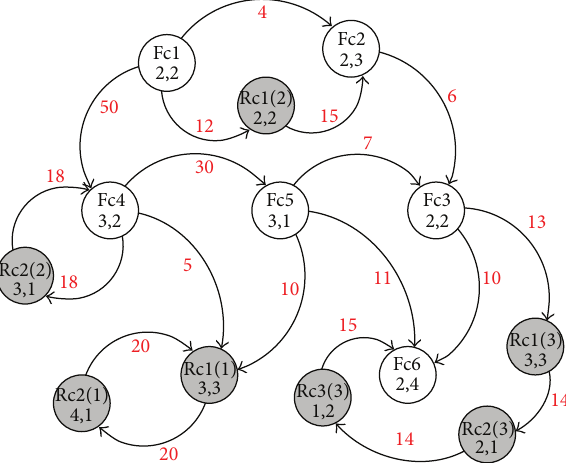
Figure 3: The EAPCG of the synthetic application Big